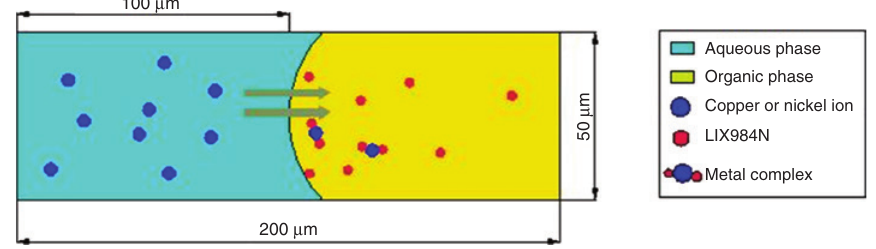
Figure 4: Schematic of the cross-section of the main